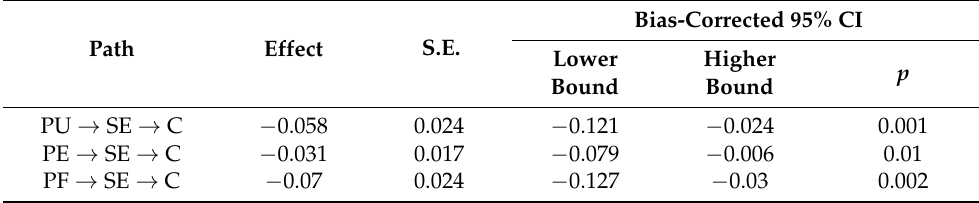
Table 7. Mediating effect